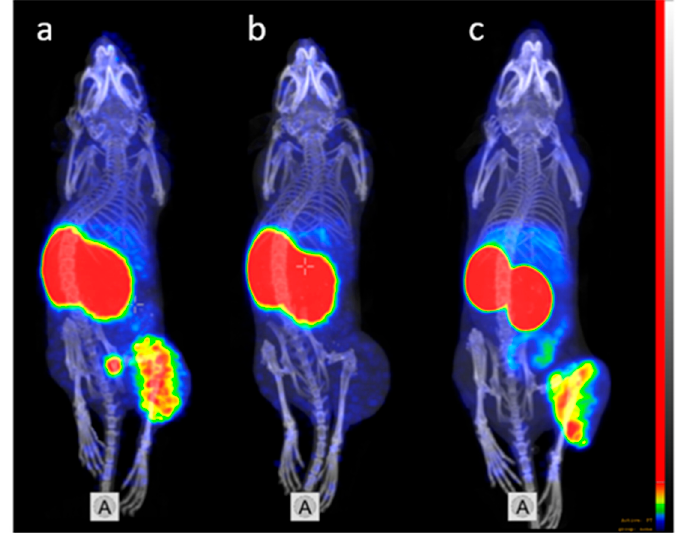
Figure 9. Micro PET/CT imaging of EGFR-expression in A431 xenografts using ( a ) [ 68 Ga]Ga-DFO-ZEGFR:2377 and ( c ) [ 89 Zr]Zr-DFO-ZEGFR:2377 at 3 h post injection. The mice were injected with 5 MBq (38 µ g) of conjugates. To confirm the EGFR-specificity of [ 68 Ga]Ga-DFO-ZEGFR:2377 accumulation in xenografts, receptors were saturated in one animal ( b ) by subcutaneously injection of 10 mg of cetuximab at 24 h before injection of [ 68 Ga]Ga-DFO-ZEGFR:2377. The color scale has been adjusted to provide clear visualization of tumors.